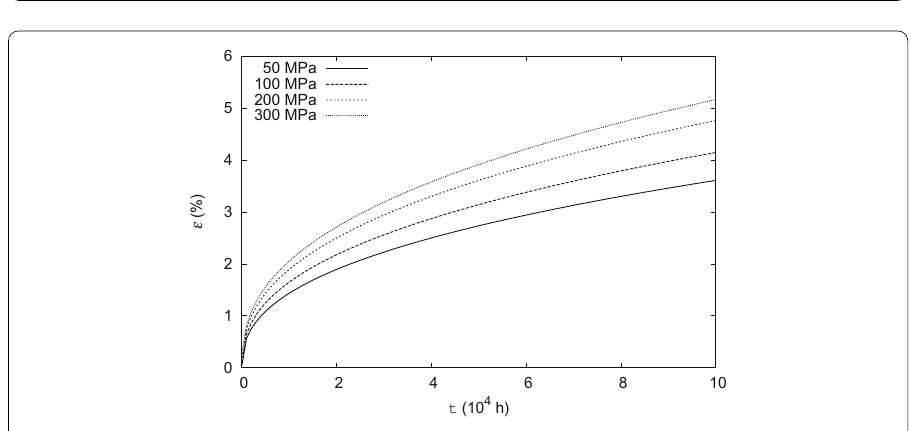
Fig. 12 Creep curves ε ( t ) at different stress levels as predicted by the present model (from Ref.